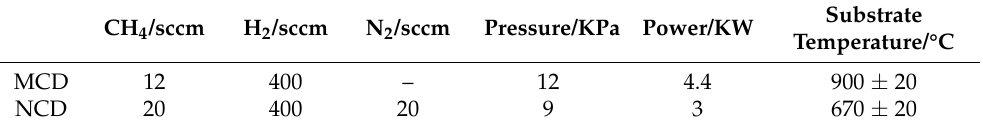
Table 1. Synthesis parameters of MCD and NCD